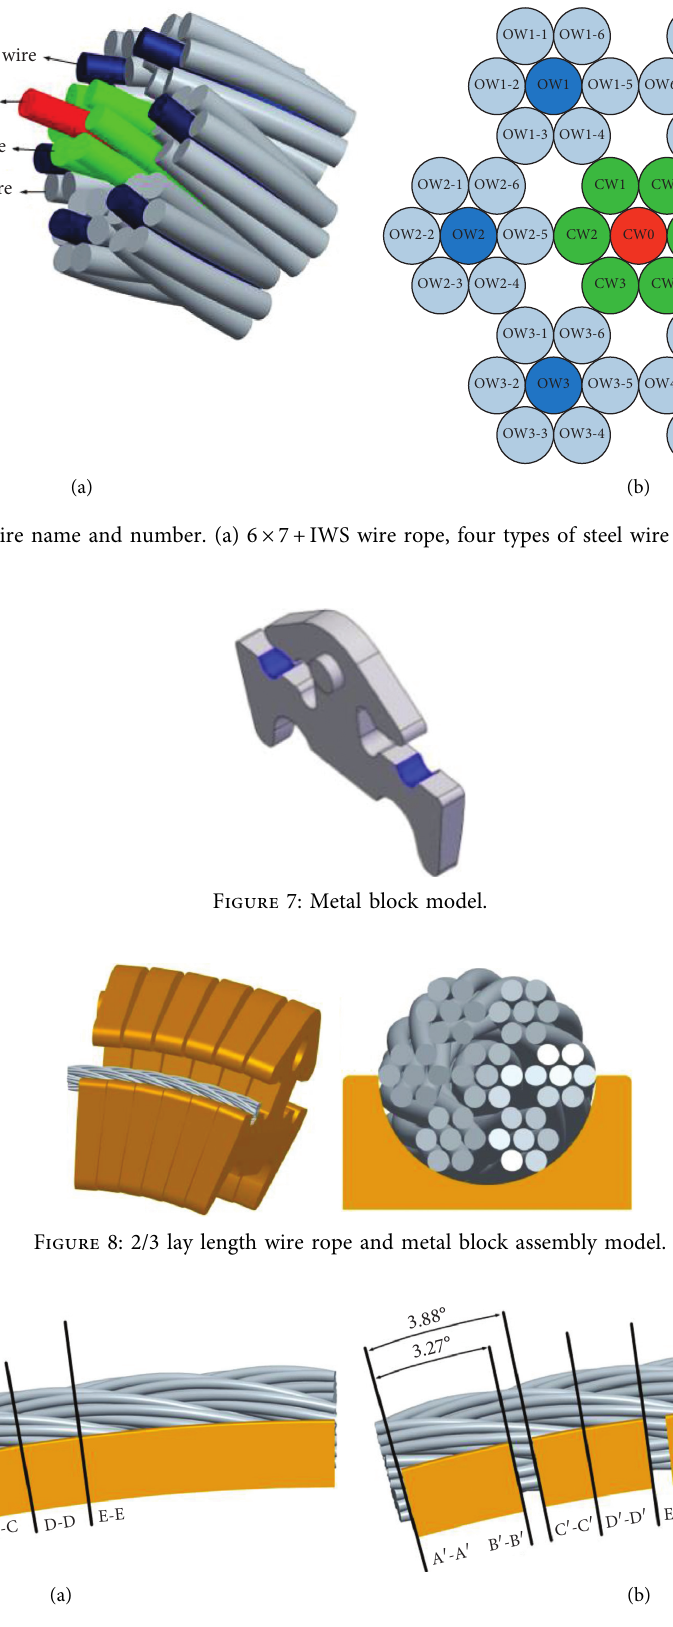
Figure 9: Sectional definition of the 3D model of continuous and discontinuous steel ring. (a) Sectional division of the continuous contact model. (b) Sectional division of the discontinuous contact